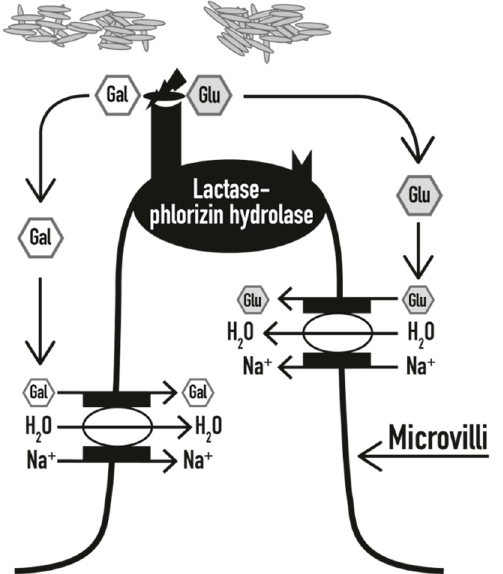
Figure 1 . In the presence of an adequate amount of lactase, lactose is hydrolysed into galactose (Gal) and glucose (Glu), which are rapidly absorbed into the bloodstream, together with H 2 O molecules (modified from [5]).